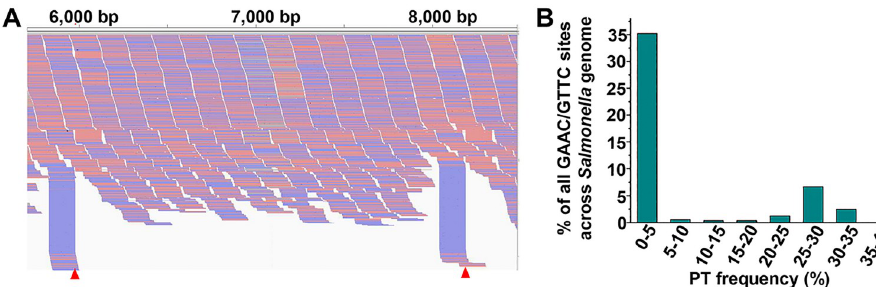
Fig 6. PT-IC-seq of S . enterica serovar Cerro 87 genome reveals low PT modification frequency globally. (A) The snapshot of genome browser representing partially modification site in bacteria genome. The top track shows counts of 5’ ends in the selected region. Blue segments represent reads mapped to minus strand and red segments represent reads mapped to plus strand. The red triangle marks two partial PT sites in S . enterica serovar Cerro 87 genome. (B) The ratio of the I 2 -specific-cleavaged reads to all the reads across the site and the PT ratio falling in the range of proportions. Statistics analysis of the PT modification frequency in the genomes of S . enterica serovar Cerro 87. All the PT modified sites in the genomes of S . enterica serovar Cerro 87 are also partially-PT modified, and about 35% of the PT modified sites with the PT ratio lower than 5%.